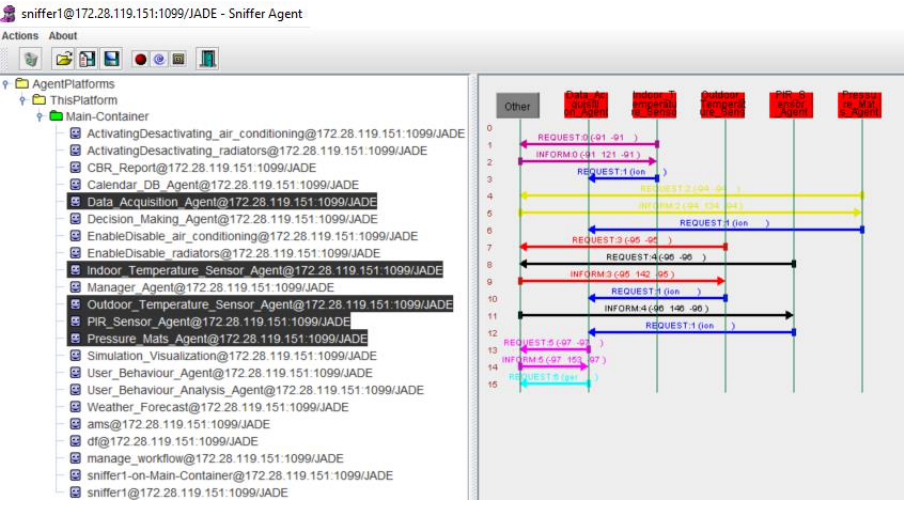
Figure 10. Communication between the agents of the data acquisition layer.